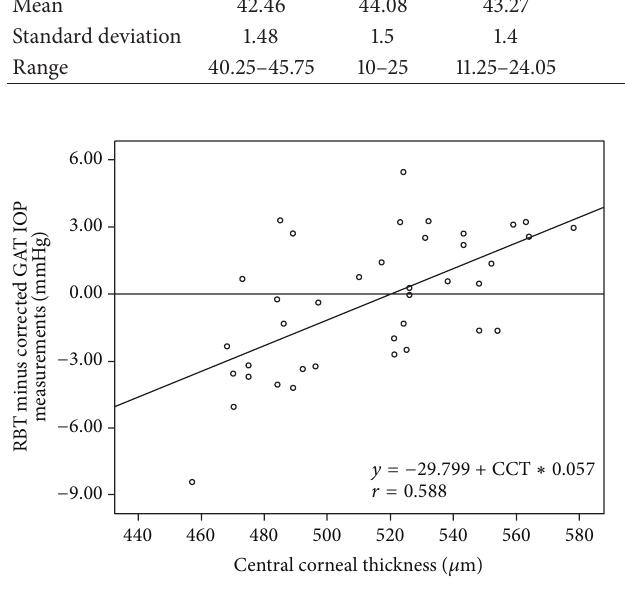
Figure 1: Correlation between CCT and the deviation of the RBT measurements from the corrected GAT values calculated according to the formula derived from the studies of Doughty and Zaman [15].